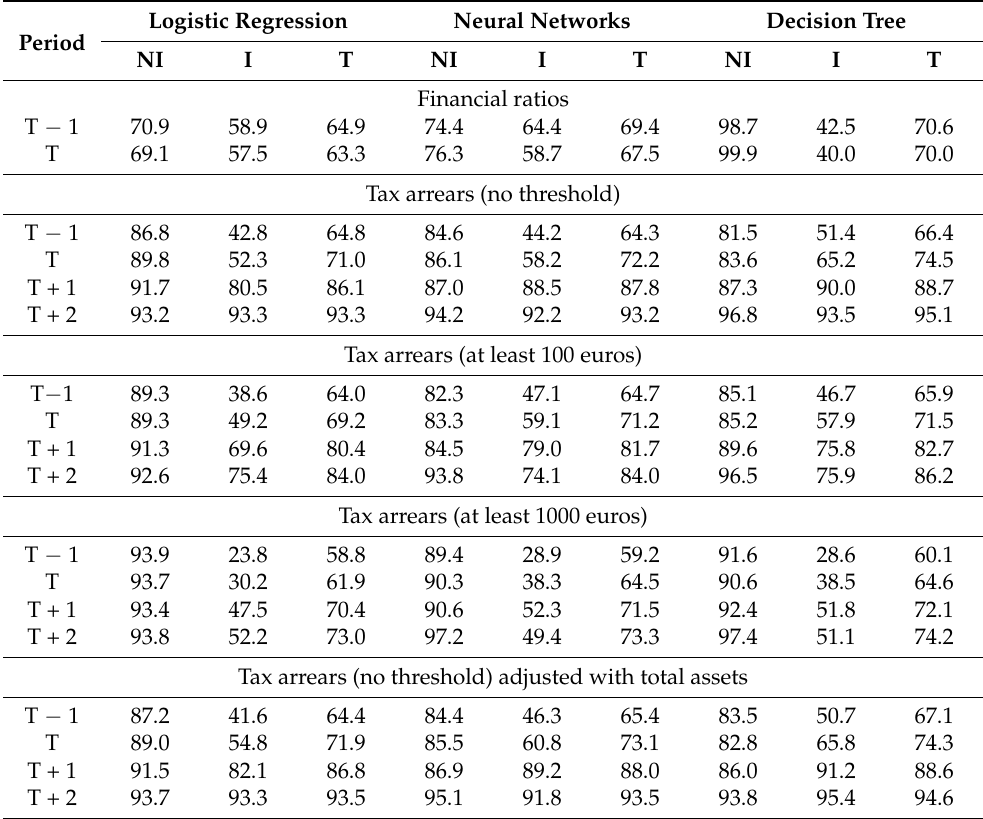
Table 4. Accuracies (% for non-insolvent, insolvent, total) of models constructed with logistic regression, neural networks, and decision